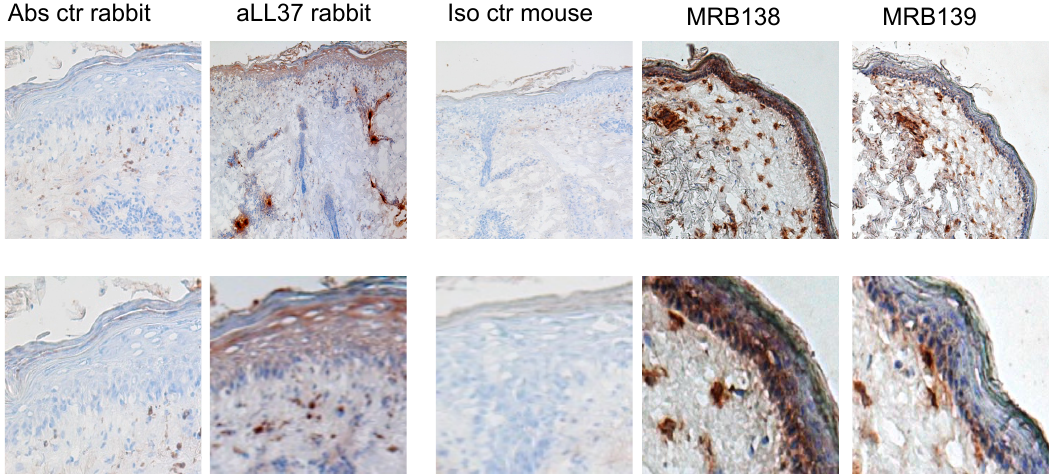
Figure 7. MRB138 and MRB139 recognize native LL37 and cit-LL37 in di ff erent locations in SLE skin. Frozen skin of LE patients was stained with MRB138 or MRB139 as described in Materials and methods. As reference, skin was also stained with polyclonal rabbit anti-LL37 (Innovagen) (See also Figure 7) as indicated. Control antibody staining was also performed. Representative experiments of two performed. Magnification: 20 × , insets in the lower